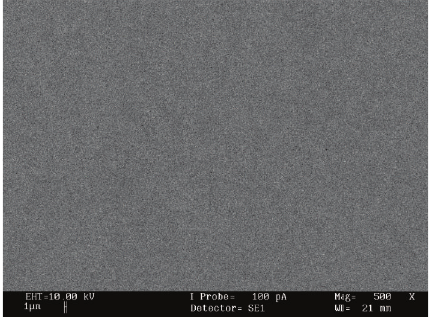
Figure 5: Scanning electron microscopy (SEM) image for CS:LiTf (90 :10)